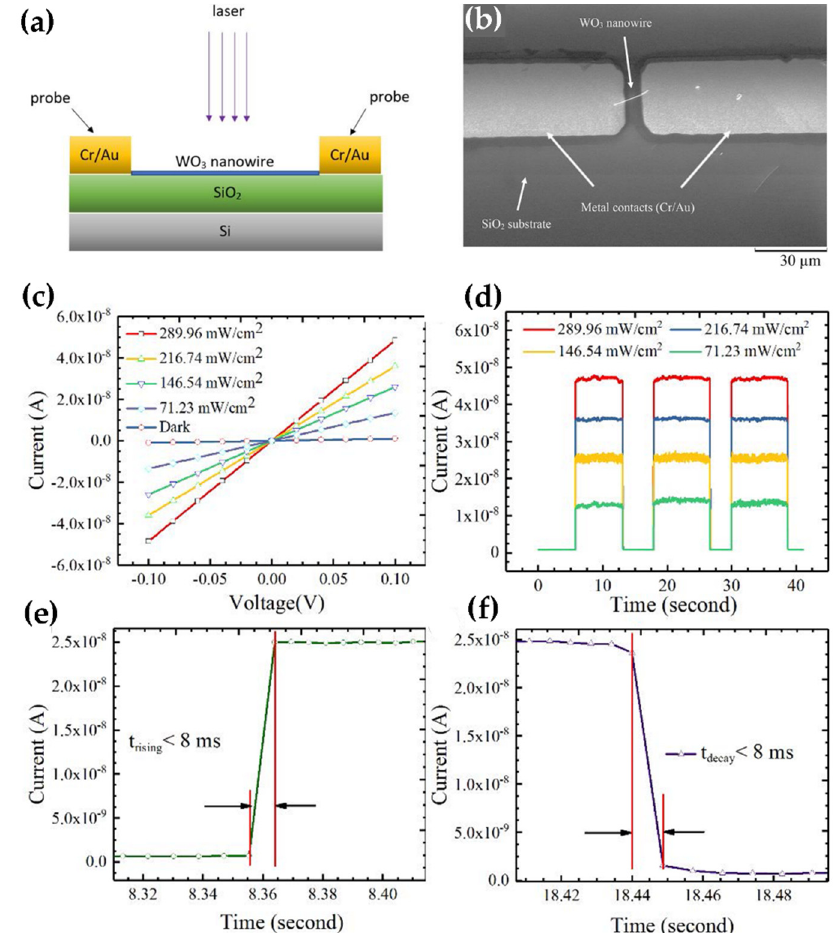
Figure 6. ( a ) Sketch of the WO 3 nanowire device structure; ( b ) SEM image of the WO 3 nanowire device. ( c ) Current − voltage curves and ( d ) photo − switching behavior of the WO 3 nanowires photodetector under the illumination of a 404 nm laser with different laser intensities. ( e , f ) are the rising time and decay time of the WO 3 nanowire photodetector. Reproduced or adapted from [27].